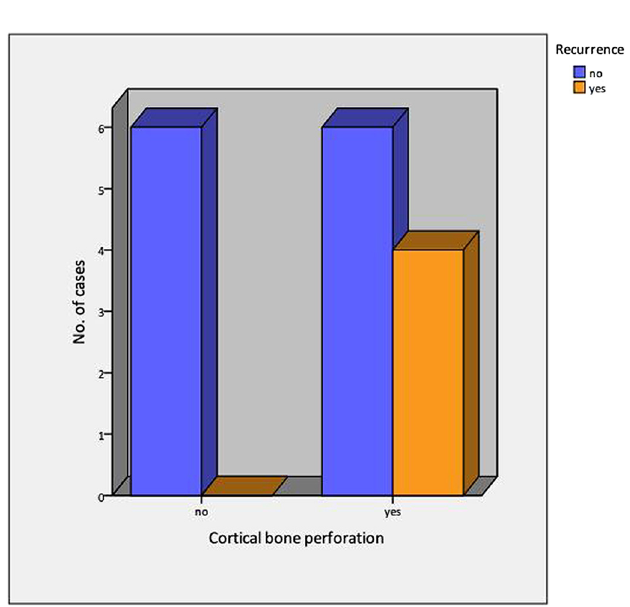
Fig. 4. Bar chart showing the correlation between cortical bone perforation and lesions